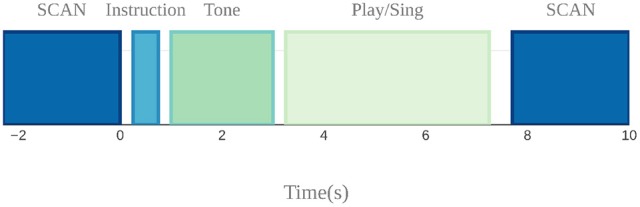
Sparse sampling design used to avoid auditory and motion artifacts. Auditory target presentation, instruction presentation, and singing and cello playing were done in the silent 7.7 s period between scans.